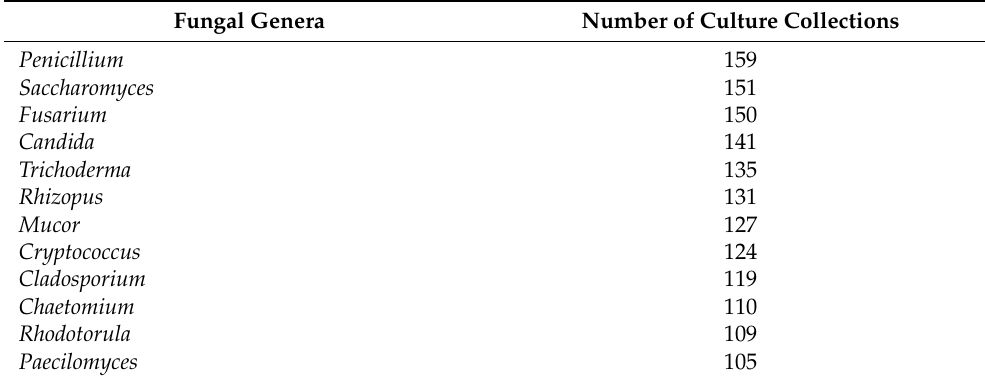
Table 3. Fungal genera preserved in the maximum number of collections (on 2 June